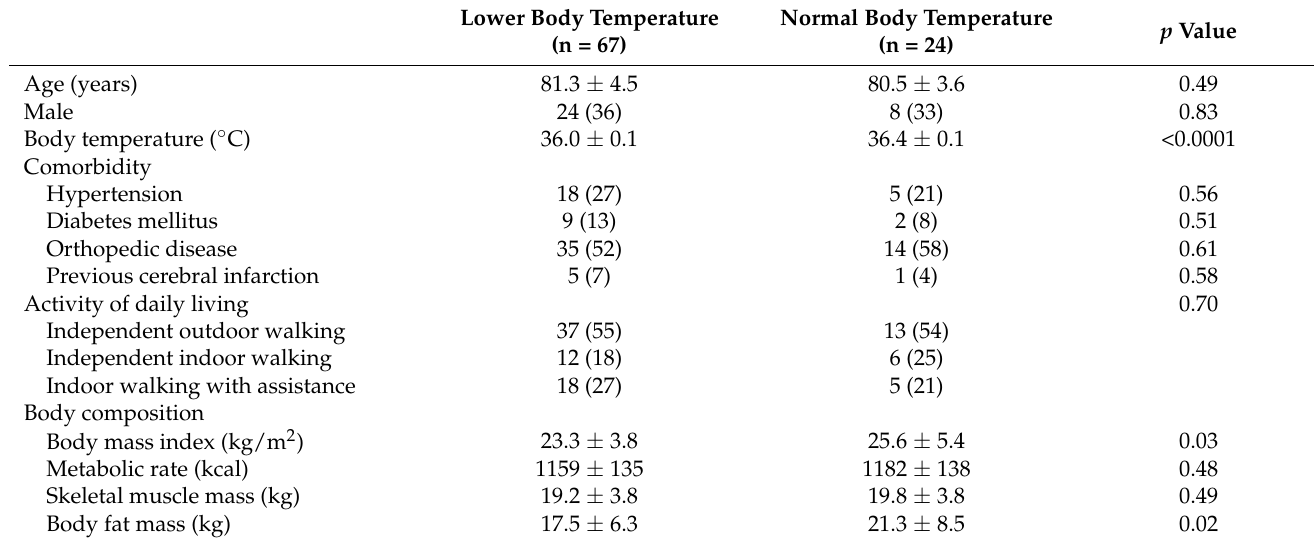
Table 1. Baseline clinical